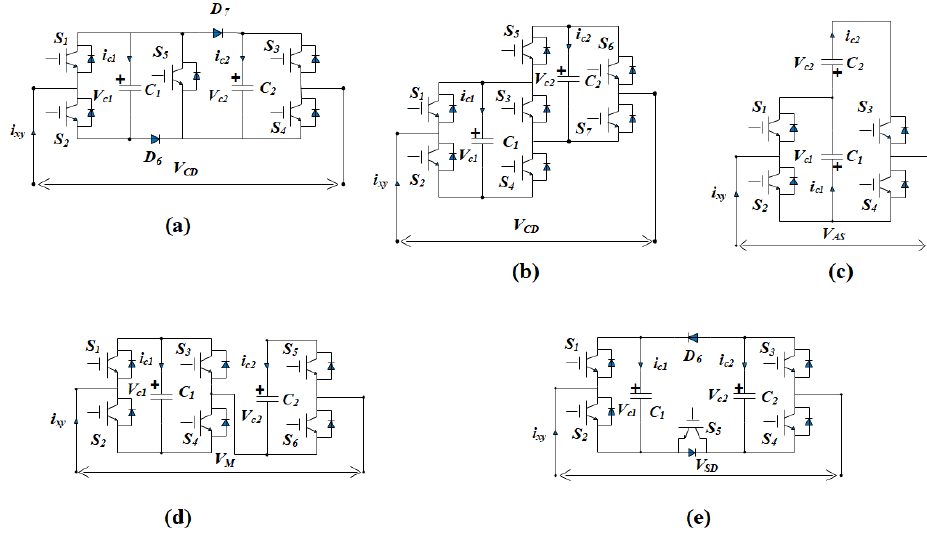
Figure 4. Four-level submodule variants ( a ) Clamp Double Submodules (CDSM), ( b ) Clamp Double Submodules (CDSM), ( c ) Mixed SM, ( d ) Asymmetrical SM, ( e ) Series Connected Double SM (SDSM).